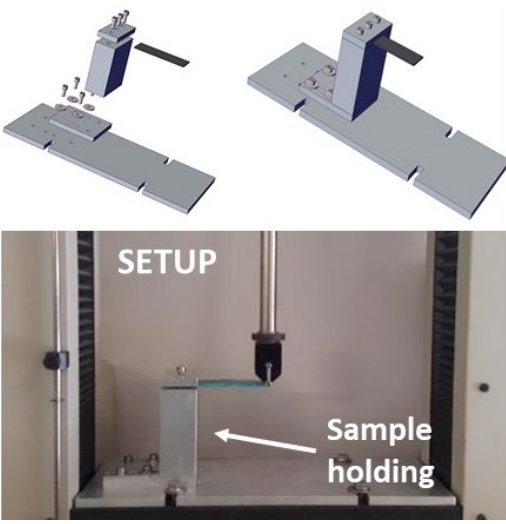
Figure 2. Device and configuration for SMP